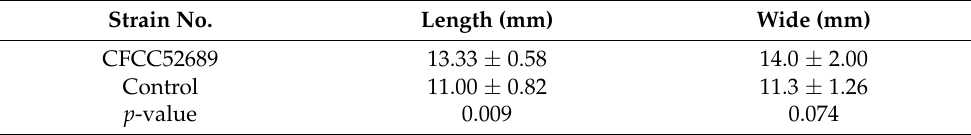
Table 2. Lesions observed in the inner bark of Larix olgensis two months after inoculation with Ceratocystiopsis subelongati